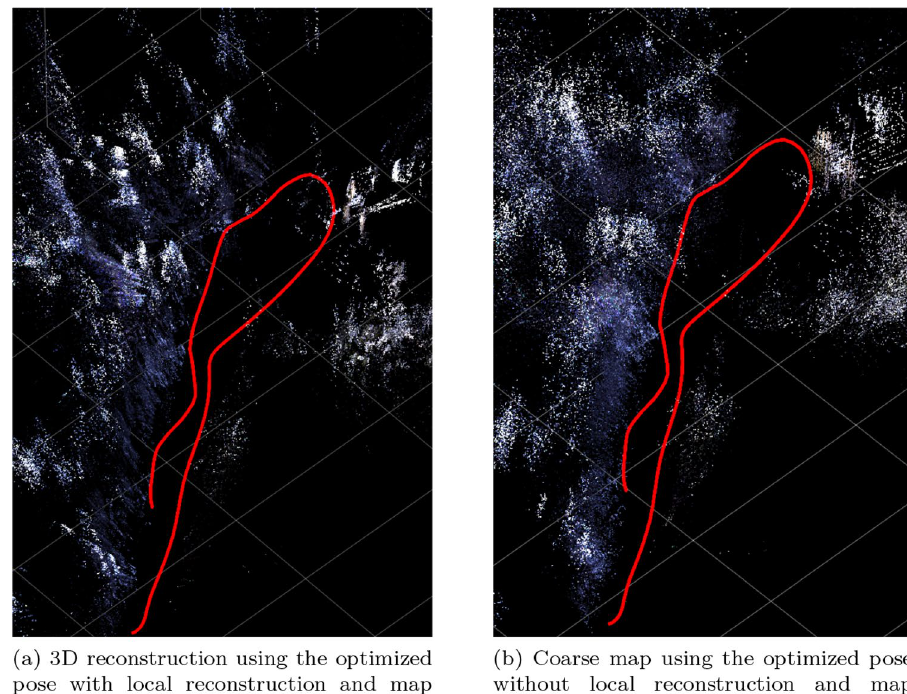
Fig. 12 Laser-generated point cloud, showing the same scene as a colorless point cloud and a colored mesh